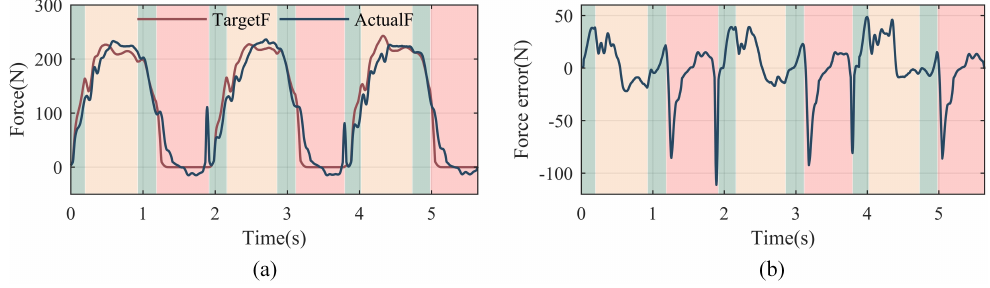
Figure 13. Output force curves of the SPEA when the exoskeleton is walking. ( a ) Target force and actual force curves. ( b ) The force tracking error curve. The red curve indicates the target force based on dynamic calculation and the blue curve indicates the actual output force of the SPEA. The green background indicates the walking state with both legs standing. The yellow background indicates the walking state with the left leg standing and the right leg swinging. The red background indicates the walking state with the left leg swinging and the right leg